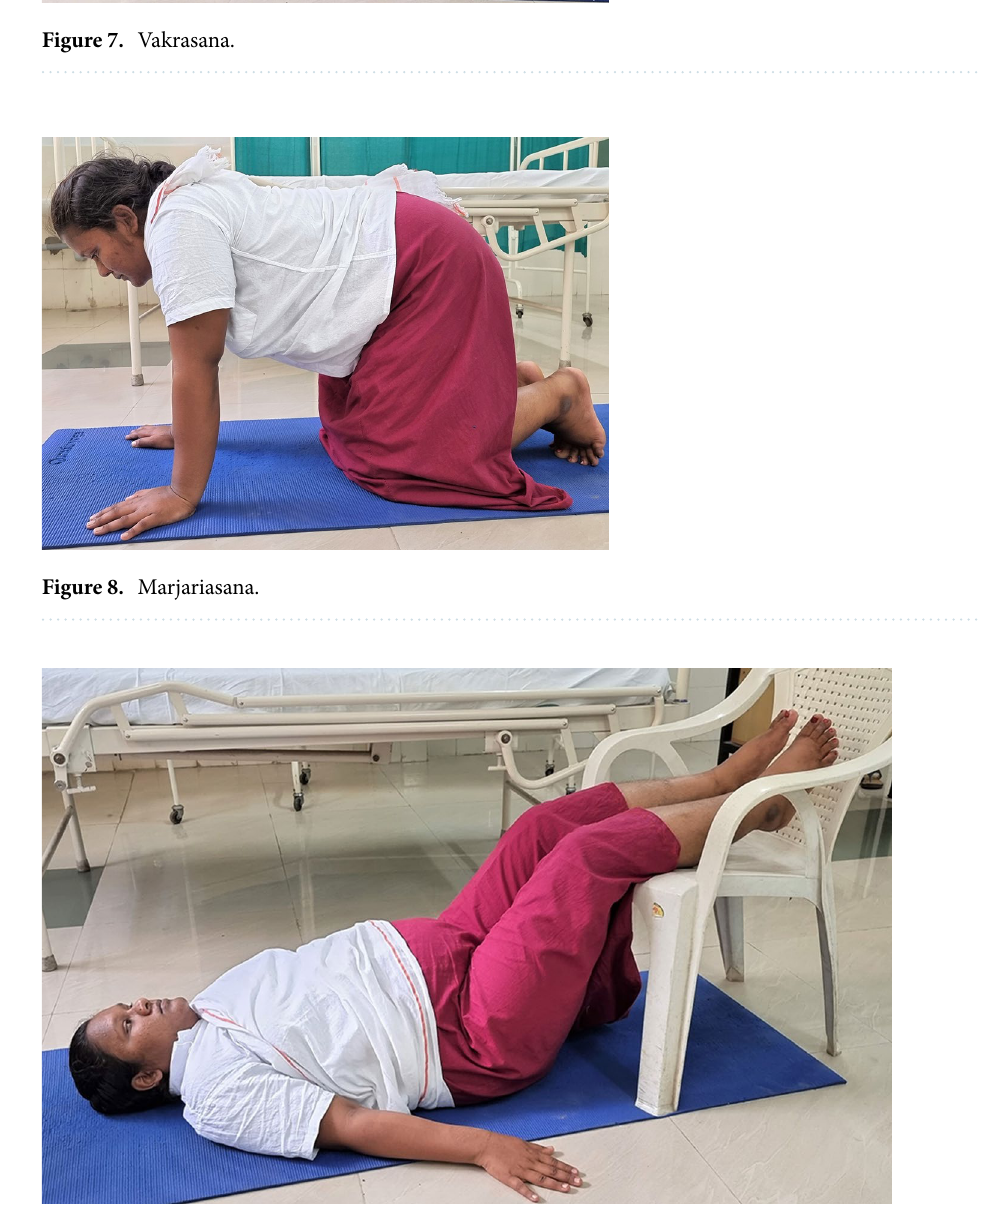
Figure 9. Uthita Padasana